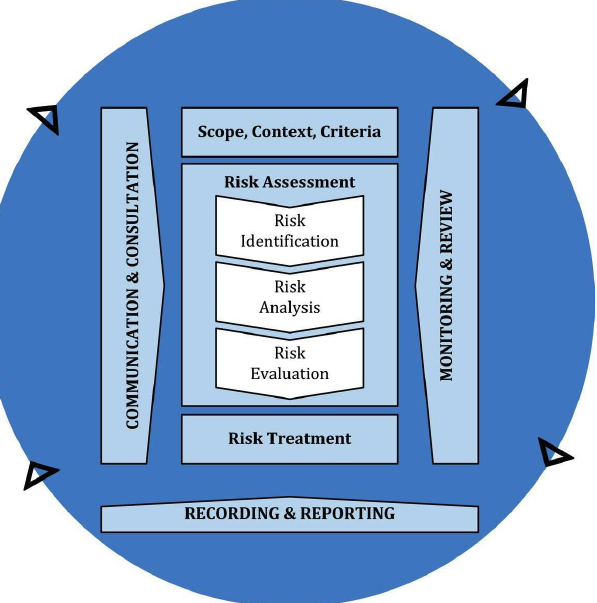
Figure 4. Risk management process. Reprinted with permission from [79]. 2018, UNI Ente Italiano di Normazione.